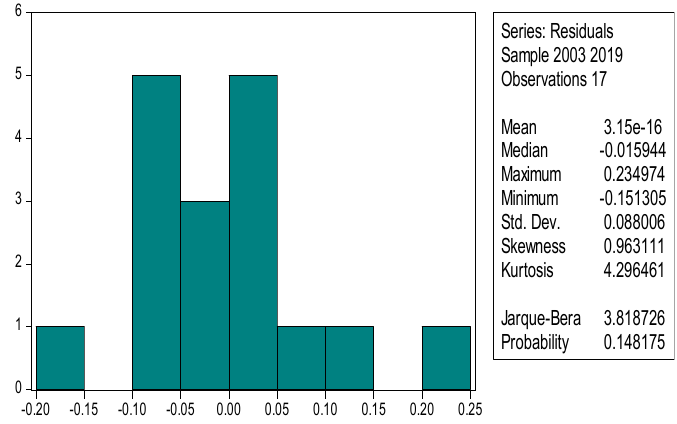
Figure 1. Histogram normality.